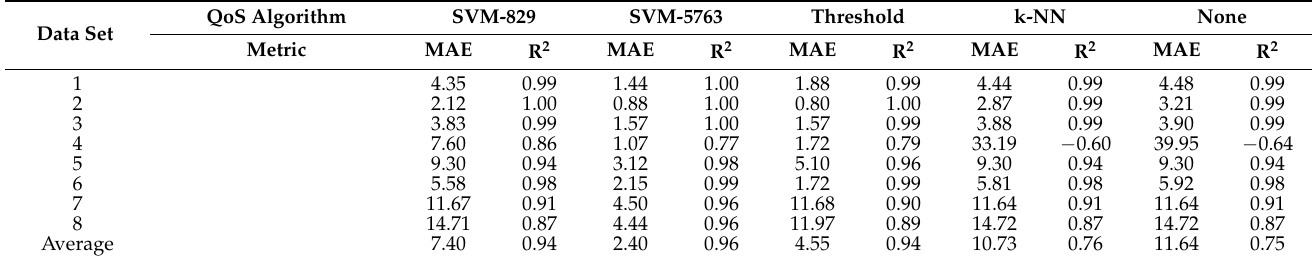
Table 5. Prediction of distance with data quality indication algorithms and without data quality indication. Data Set